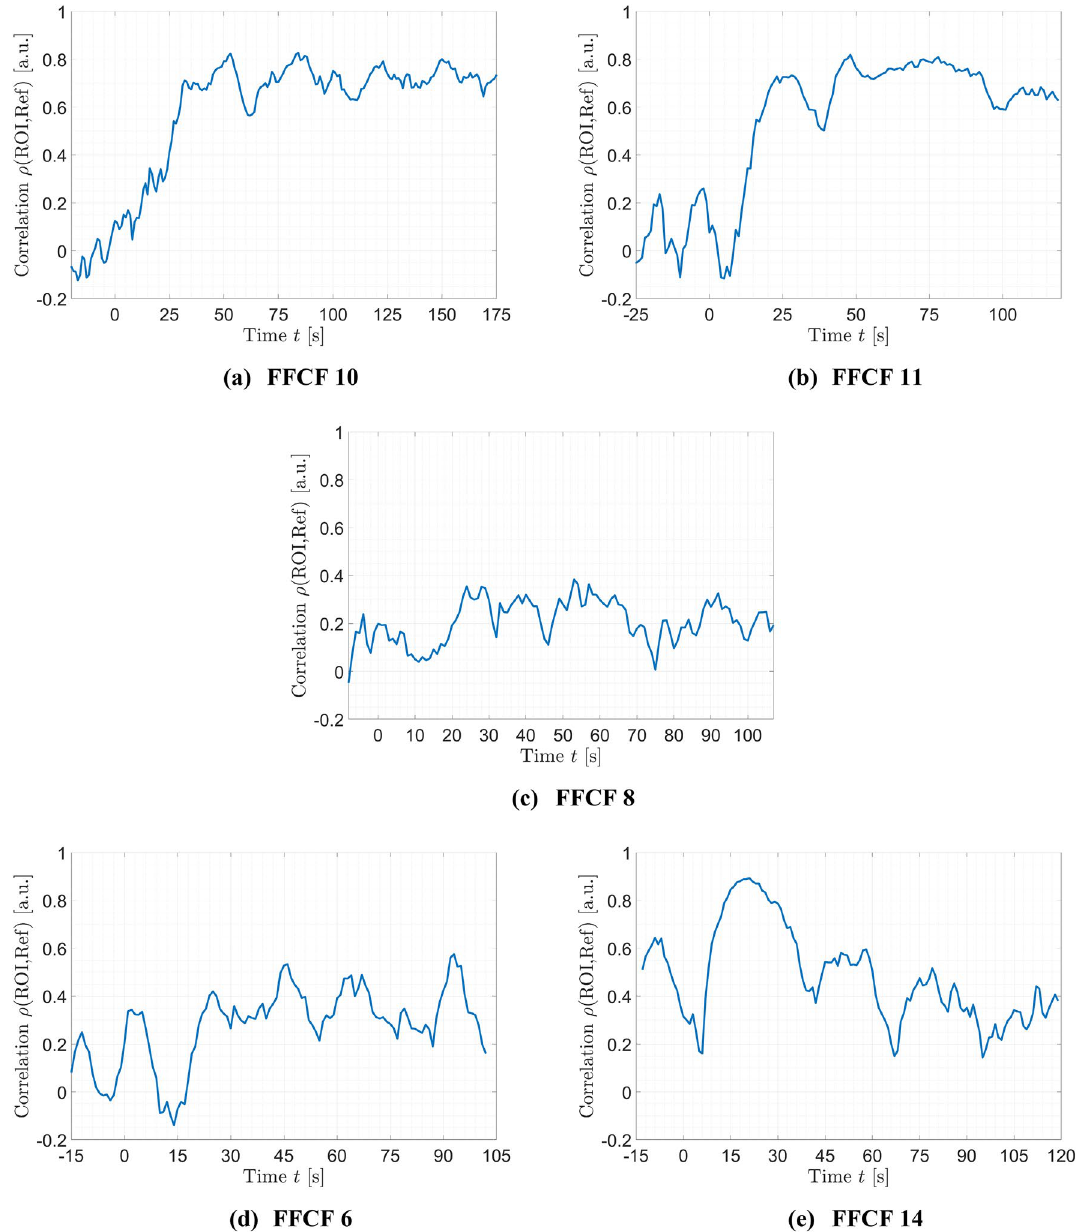
Figure 7. rPPG correlation ρ of selected cases. The documented reperfusion was set to t = 0 s. ( a ) #10 and ( b ) #11 were successful, incident-free reperfusions showing an increasing correlation starting at reperfusion remaining continuously high afterwards. ( c ) The correlation of the failed flap (#8) remained at the ischemia level. ( d ) #6 and ( e ) #14 showed a correlation increase after reperfusion. Due to vasospasms, the correlation dropped in the further course to a lower